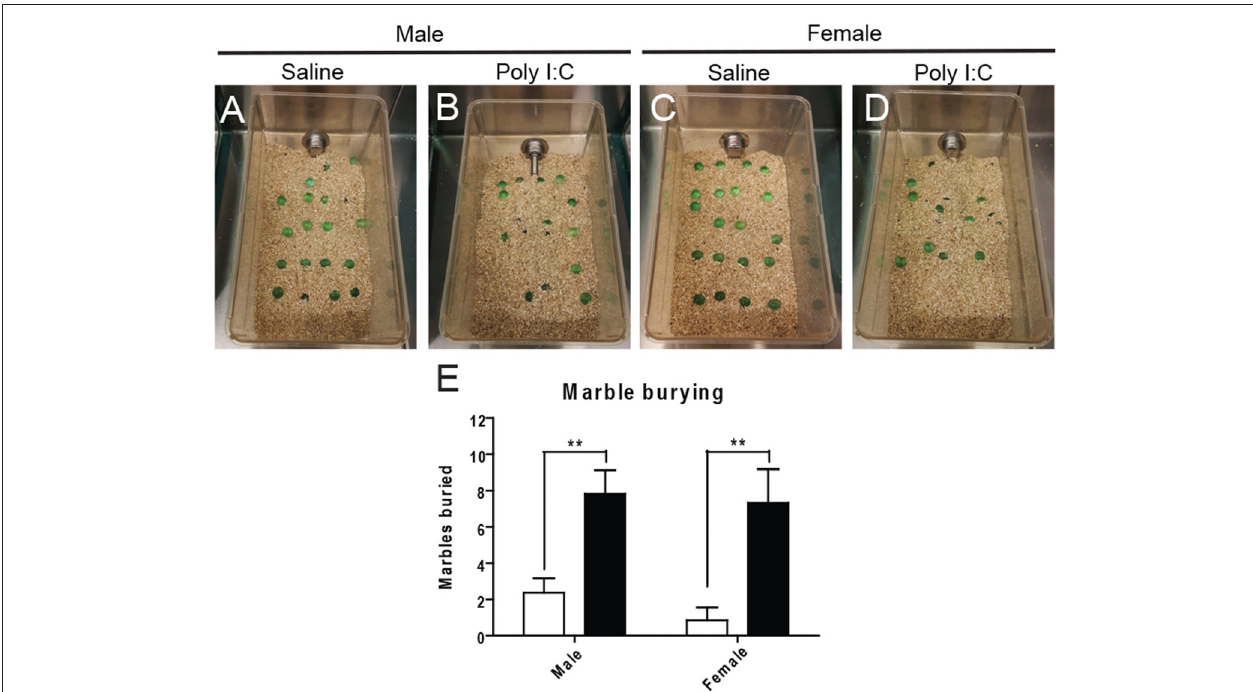
FIGURE 3 | Effects of Poly I:C on repetitive behaviors. Representative pictures of the experimental cages after marble burying are shown in (A–D) . Numbers of marbles buried as quantified in (E) . n = 6–8 mice per sex and group. ** p < 0.01.